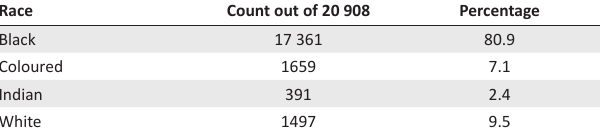
TABLE 2 : Study of population